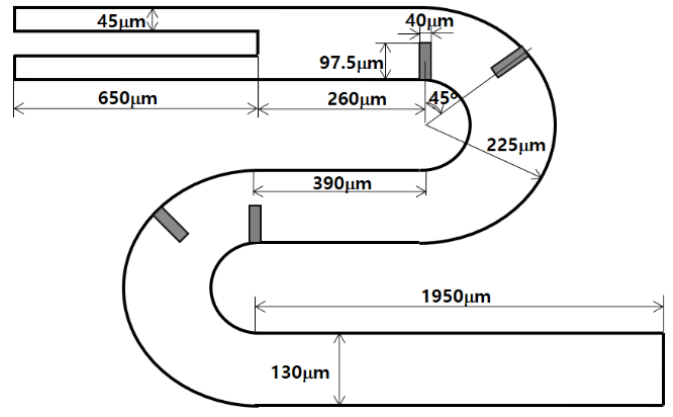
Figure 3. Diagram of the micromixer tested by Tsai et al. [19].